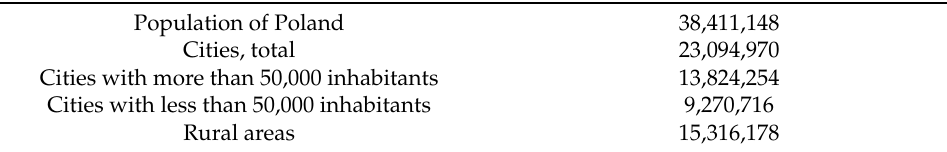
Table 5. Population of Poland in 2018 according to CSO data